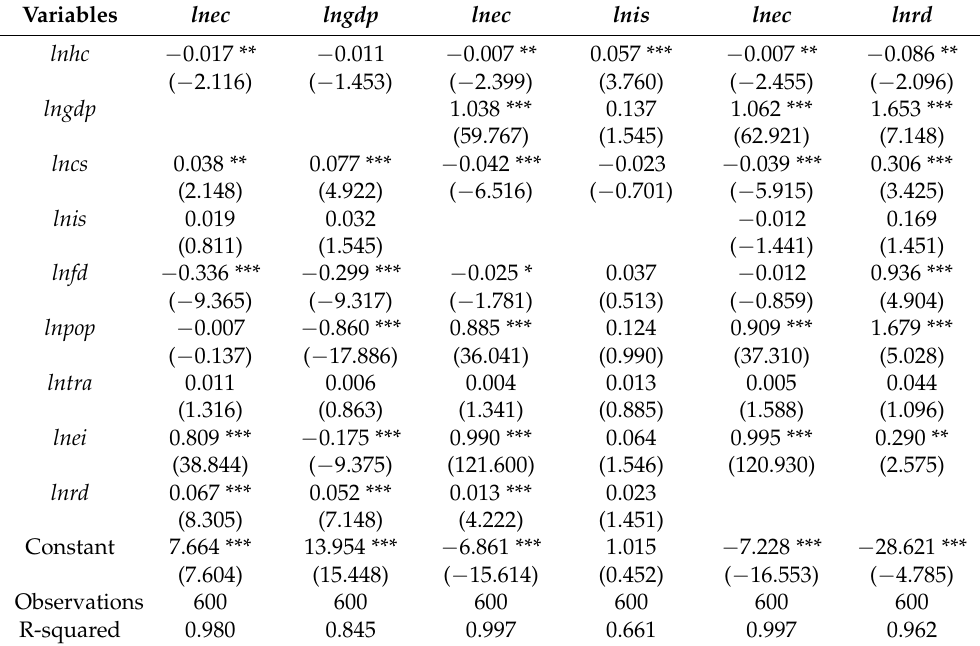
Table 3. Mechanism test